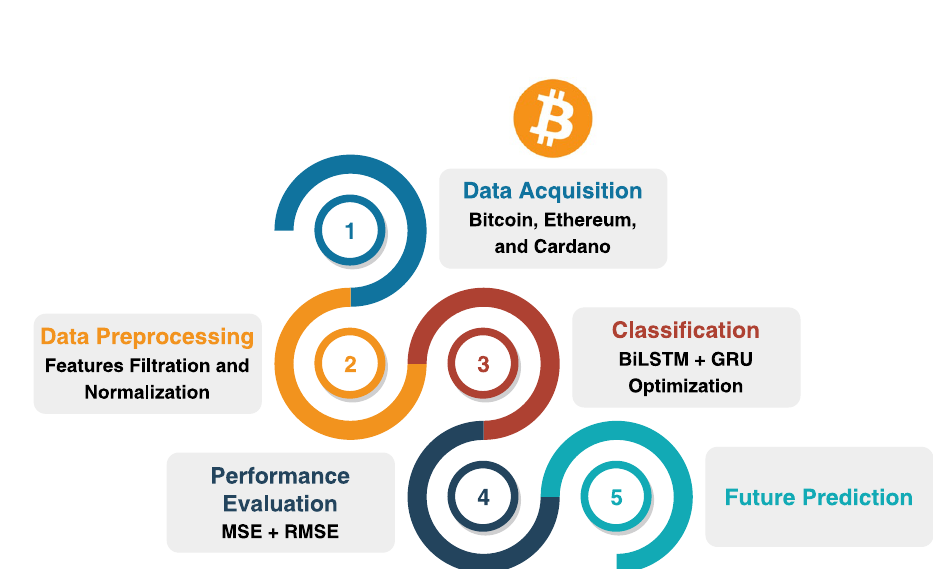
Fig. 2 The flow for a cryp- tocurrency price prediction